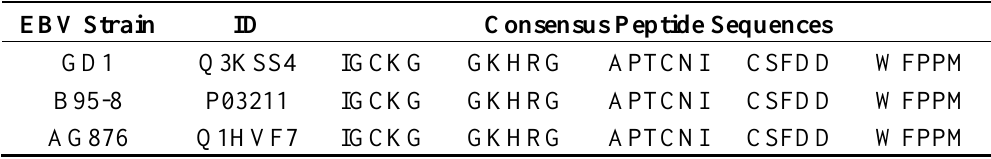
Table 3. Conservation of EBNA1 unique peptide regions among EBV GD1, B95-8, and AG876